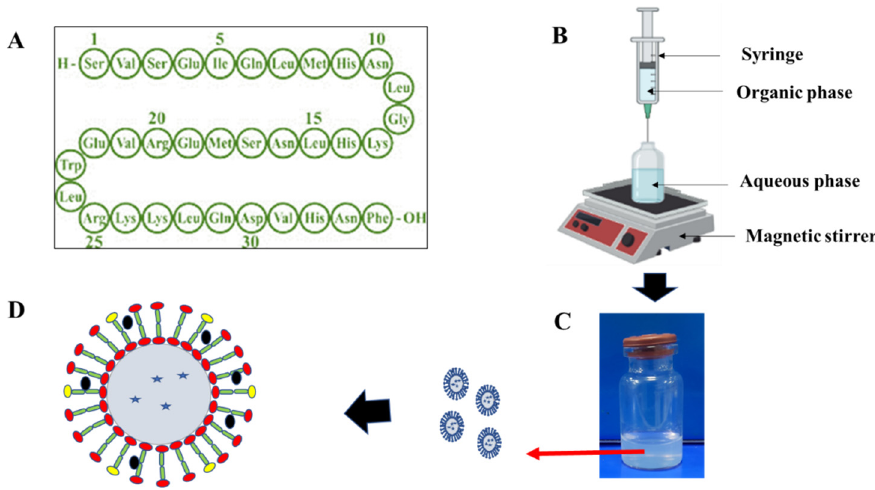
Figure 2. Development of PTH-LPs. ( A ) Amino acid sequence of PTH (1-34), ( B ) Representative instrumental setup for the development of PTH-LPs, ( C ) Vial containing dispersion of PTH-LPs, ( D ) Schematic representation of PTH-LPs.